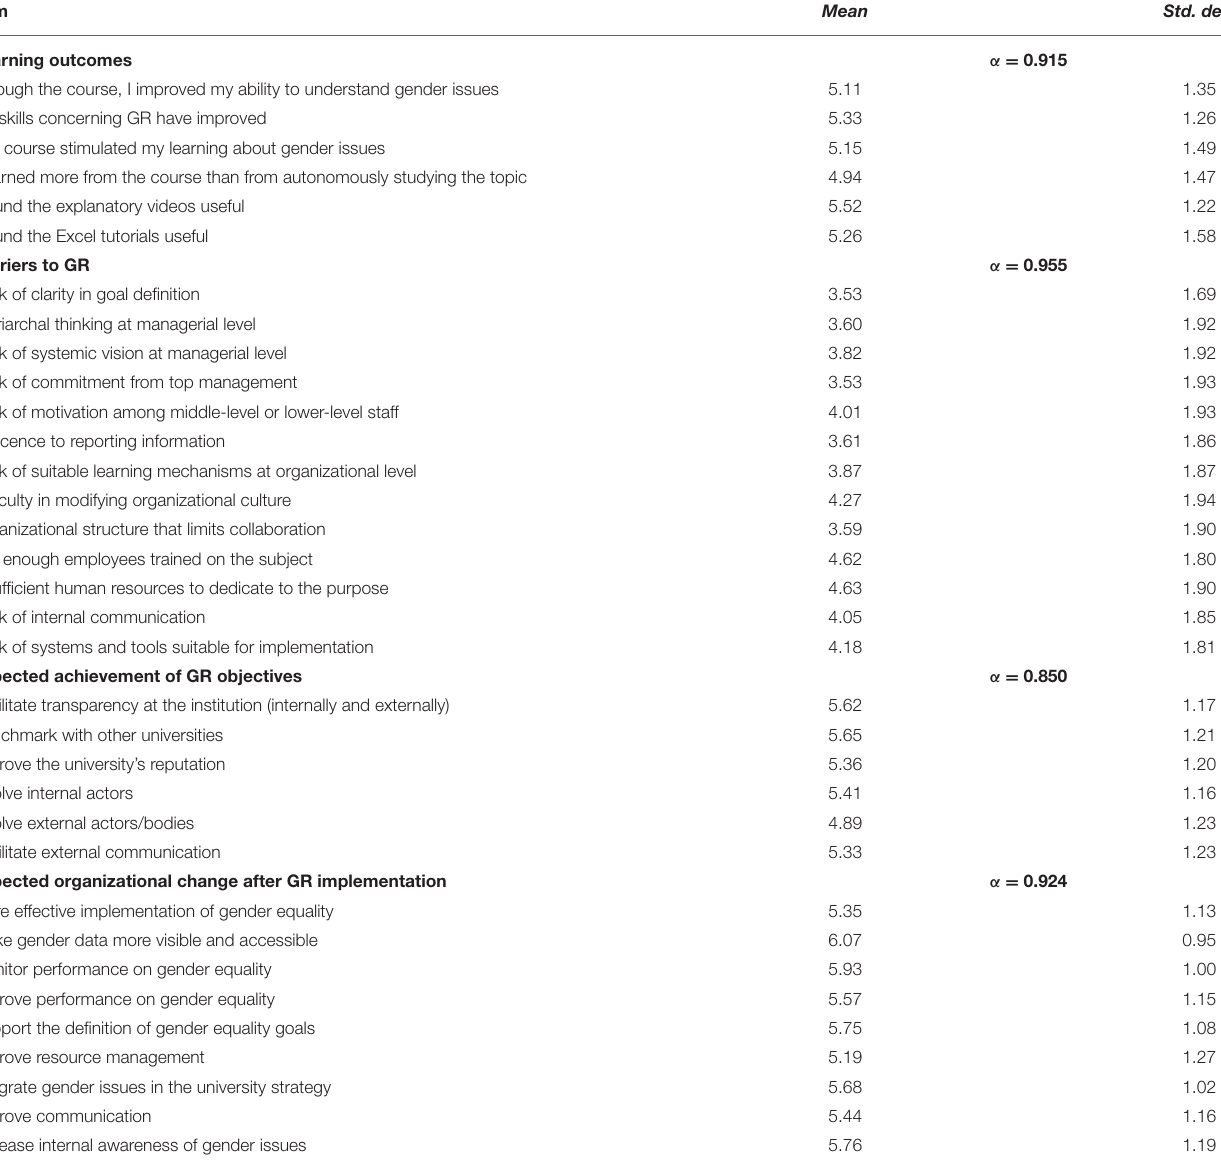
TABLE 1 | Mean and standard deviation statistics for the items, and Cronbach’s Alpha coefficients for the variables. Item